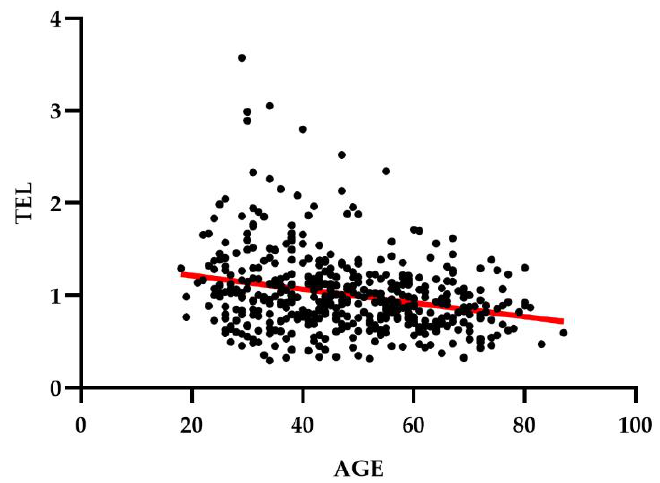
Figure 1. Flow-chart of the study.